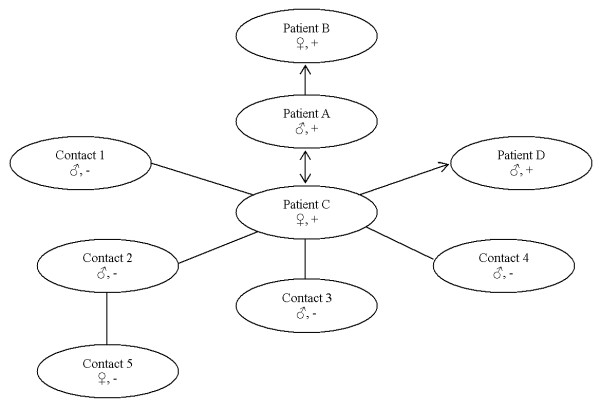
The relationship between investigated cases and their possible transmission direction. (Mars male gender symbol) indicates male; (female Venus gender symbol) indicates female; -/+ indicates the result of HIV testing; arrow indicates the possible transmission direction.